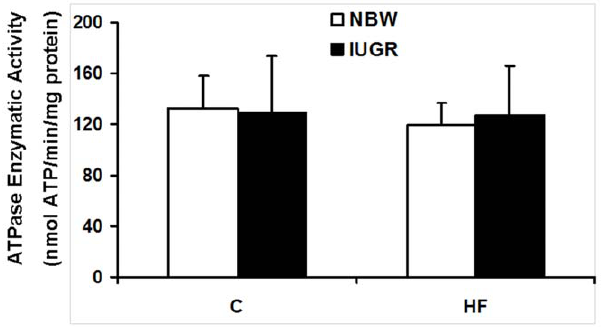
Figure 5. Influence of IUGR and diet on enzymatic activity of mitochondrial F 0 F 1 -ATPase in skeletal muscle of pigs. C: Control diet; HF: High-fat diet; NBW: Normal birth weight; IUGR: Intrauterine growth retardation. Data are expressed as group means 6 SEM. * P values next to each label represent the significance in the effect for each source of variation (IUGR or diet) as calculated by ANOVA. 1 P , 0.05 in post hoc test comparing IUGR and NBW offspring receiving the same diet (n=8 by group).